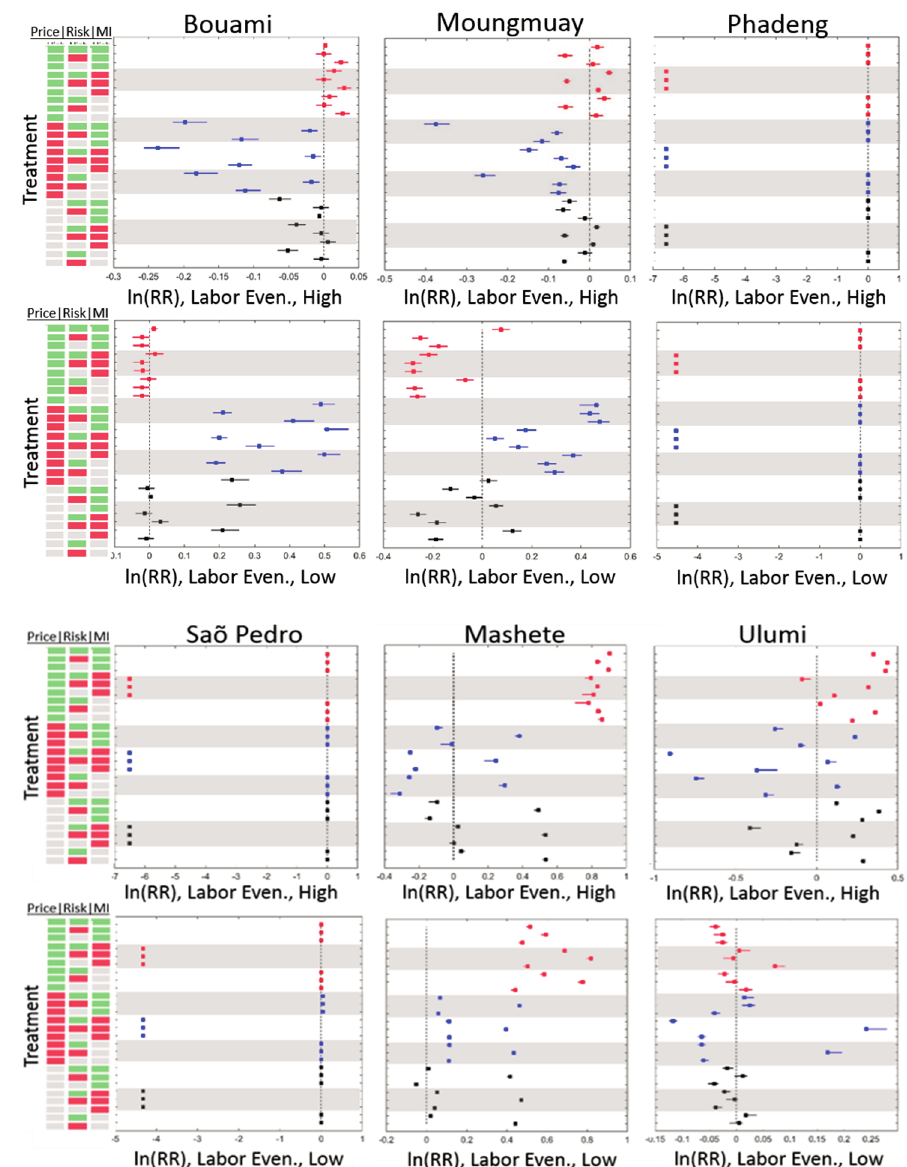
Figure 5. Mean effect sizes of experimental treatments for high (top row) and low (bottom row) labor allocation evenness ( i.e. , livelihood diversity) among household agents. Experimental treatments are indicated in the color-coded panels on the far left and are displayed as combinations of commodity price (left column), average risk preference (middle column), and market influence (MI, right column) perturbations. Green, gray, and red treatment cells indicate increased, baseline, and decreased treatment values, respectively. Effect sizes are plotted with the mean and 95% confidence interval. Interpretation. Effect sizes are significant at α =0.05 level when intervals do not include zero or do not overlap between categories [73, 74]. Within each plot, effect sizes are grouped and colored by commodity price level (red points = higher prices; blue points = lower prices; black points = baseline prices). White and gray bands group experimental treatments by market influence settings. Thus, the relative influence of risk preferences is shown by the amount of horizontal dispersion of points within a white/gray